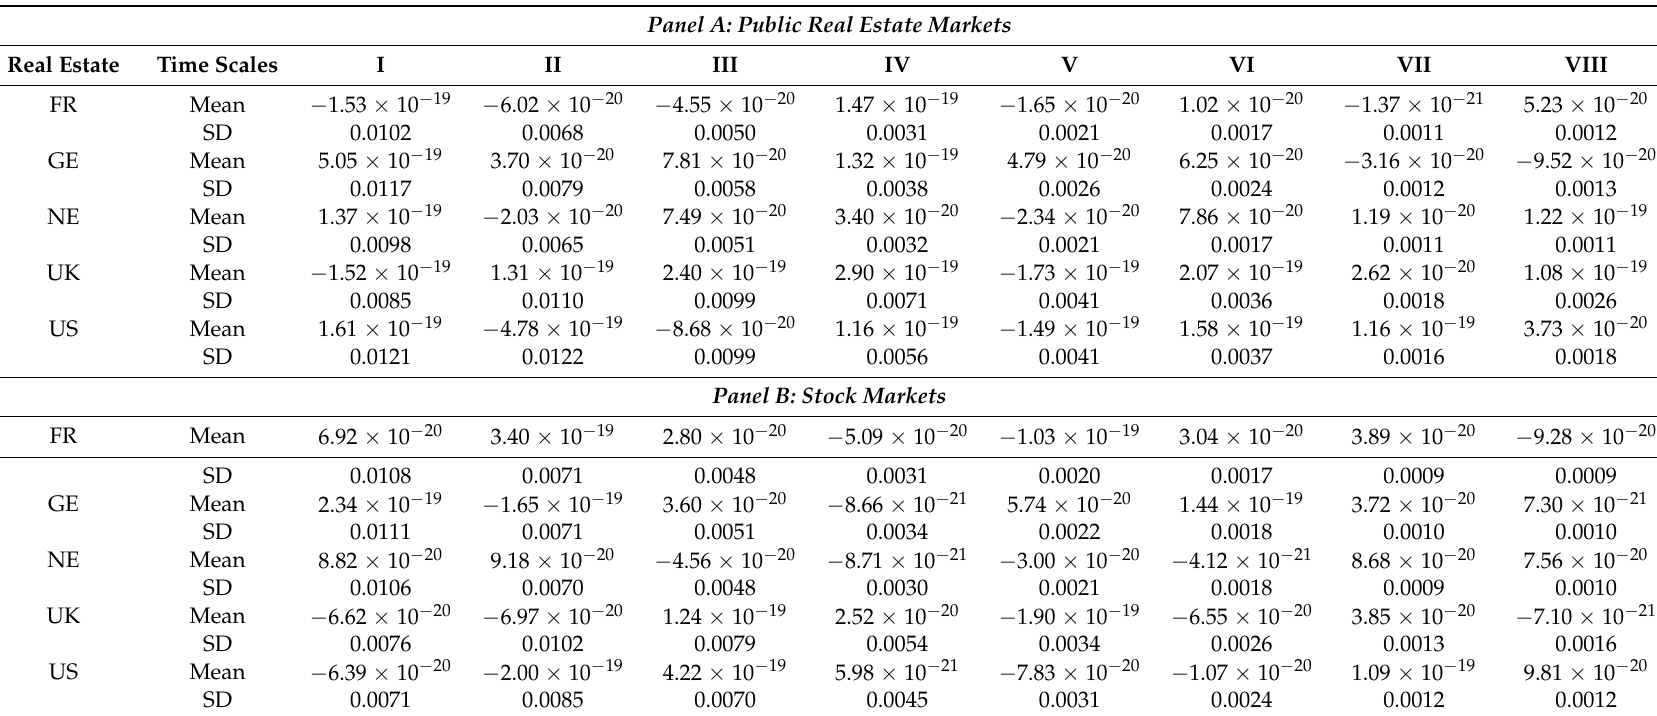
Table 2. Mean and standard deviation (SD) of decomposed returns at different scales. Panel A: Public Real Estate